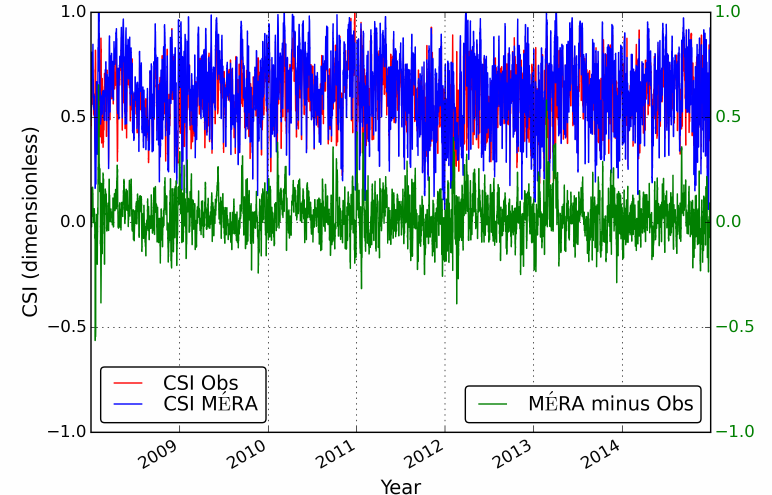
Figure 10. Time series of daily mean clear sky index (CSI) (weighted using hourly GHI) averaged over the TUCSON stations. Thirty-day averaging is applied. Observations (red), MÉRA data (blue) and the bias in MÉRA relative to observations (green) are